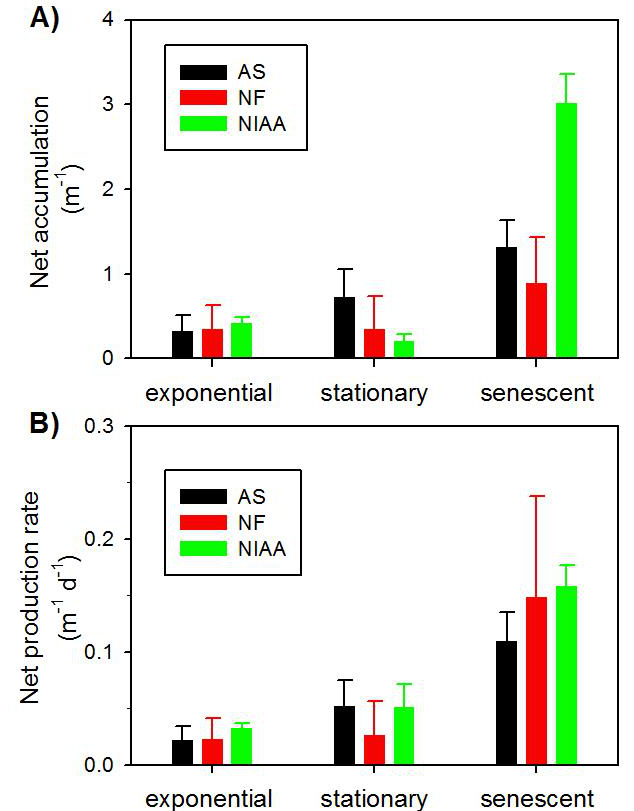
Figure 2. Net accumulation ( A ) and net production rate ( B ) of CDOM during different growth phases of the ice algal cultures. AS stands for Attheya septentrionalis, NF for Nitzschia frigida , and NIAA for natural ice algae assemblage. The absorption coefficient at 350 nm is used as a proxy of CDOM abundance. Error bars are one standard deviation of the triplicate cultures. Note that the senescent-phase values for N. frigida are not directly comparable with those of the other two cultures due to the early termination of the incubation of N. frigida .